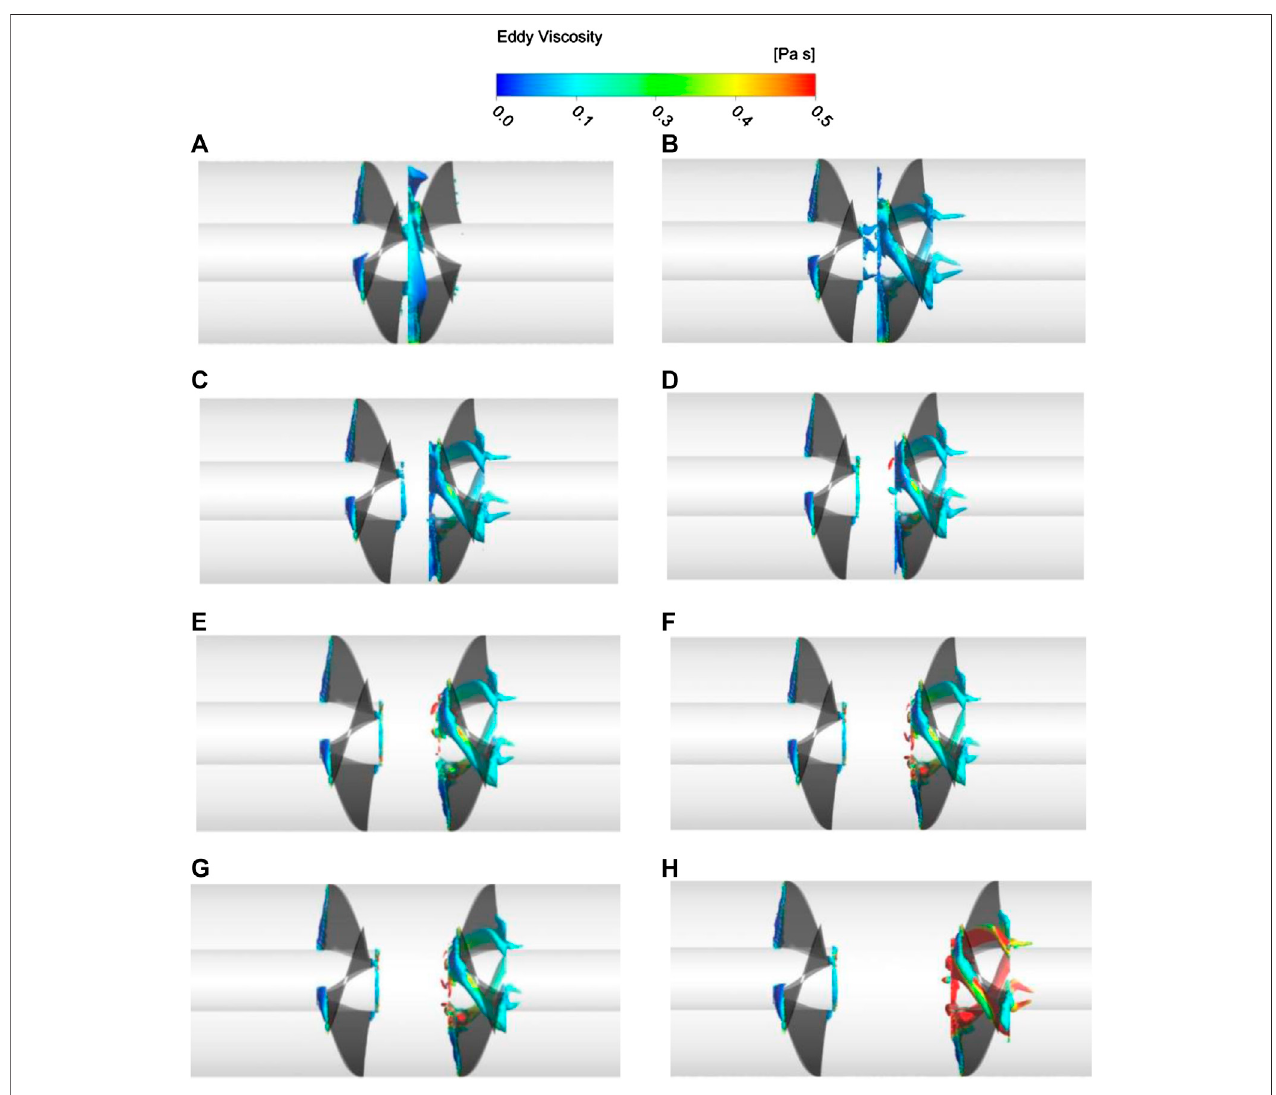
FIGURE 10 | Vortex distribution at counter-rotating impeller with different inter-stage clearances. (A) D L1 (cid:1) 0.00 L (B) D L2 (cid:1) 0.25 L (C) D L3 (cid:1) 0.50 L (D) D L4 (cid:1) 0.75 L (E) D L5 (cid:1) 1.00 L (F) D L6 (cid:1) 1.25 L (G) D L7 (cid:1) 1.50 L (H) D L8 (cid:1) 2.00